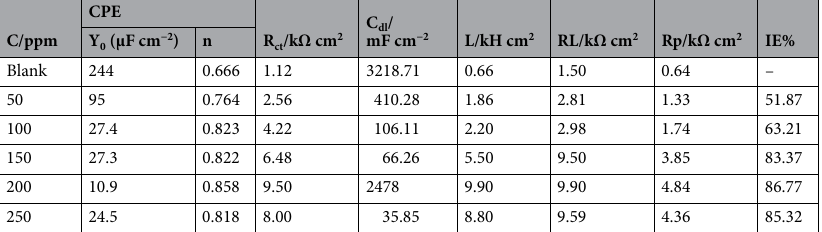
Table 5. Corrosion parameters computed of Nyquist curves of Al alloy (100 mm 2 ) in absent and presence of varies concentrations of RA/AgNPs.